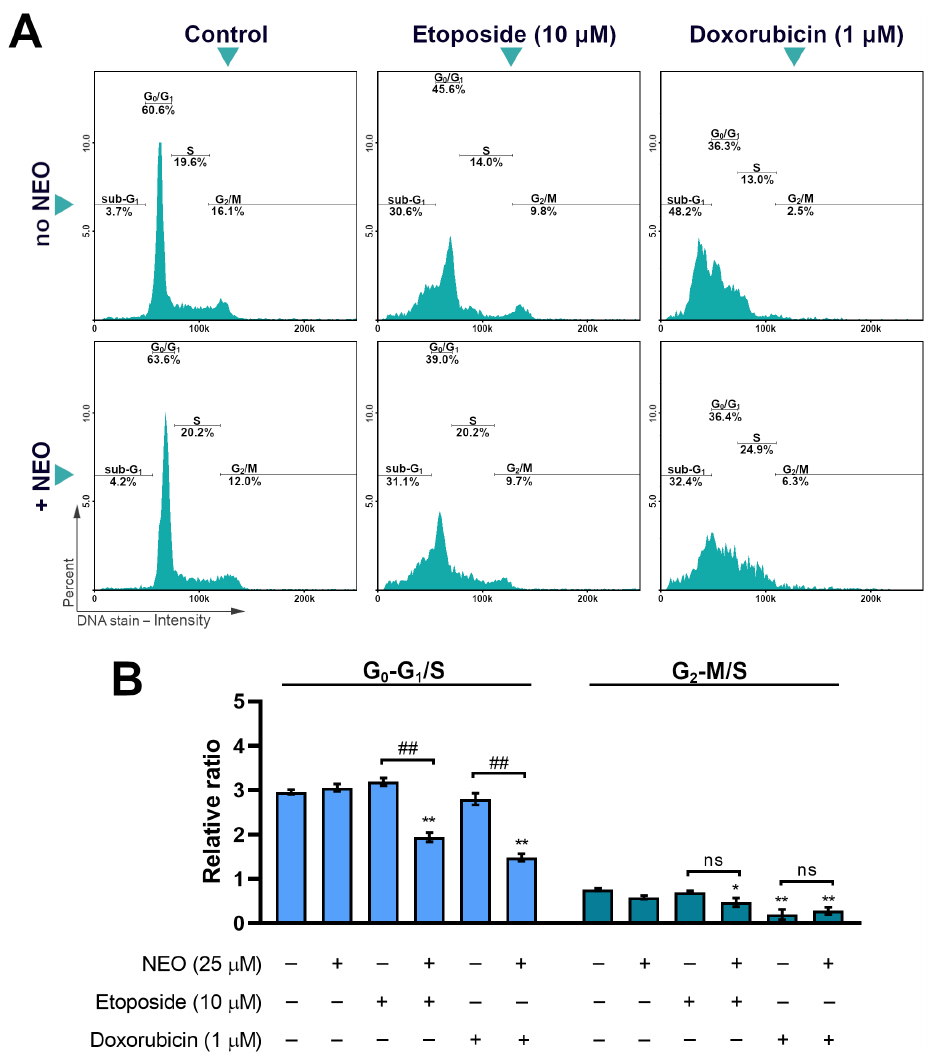
Figure 6. Changes in the cell cycle in SW1783 cells treated with doxorubicin (1 μM) or etoposide (10 μM) alone and their mixes with NEO (25 μM) for 48 h. ( A ) Representative histograms displaying the distribution of cell subpopulations in the cell-cycle phases. ( B ) Bar graph presenting results as a relative quantity ratio of G 0 -G 1 /S and G 2 -M/S. * p < 0.05, ** p < 0.001 vs. control; ## p < 0.001 for comparisons between groups; ns—non-significant difference.